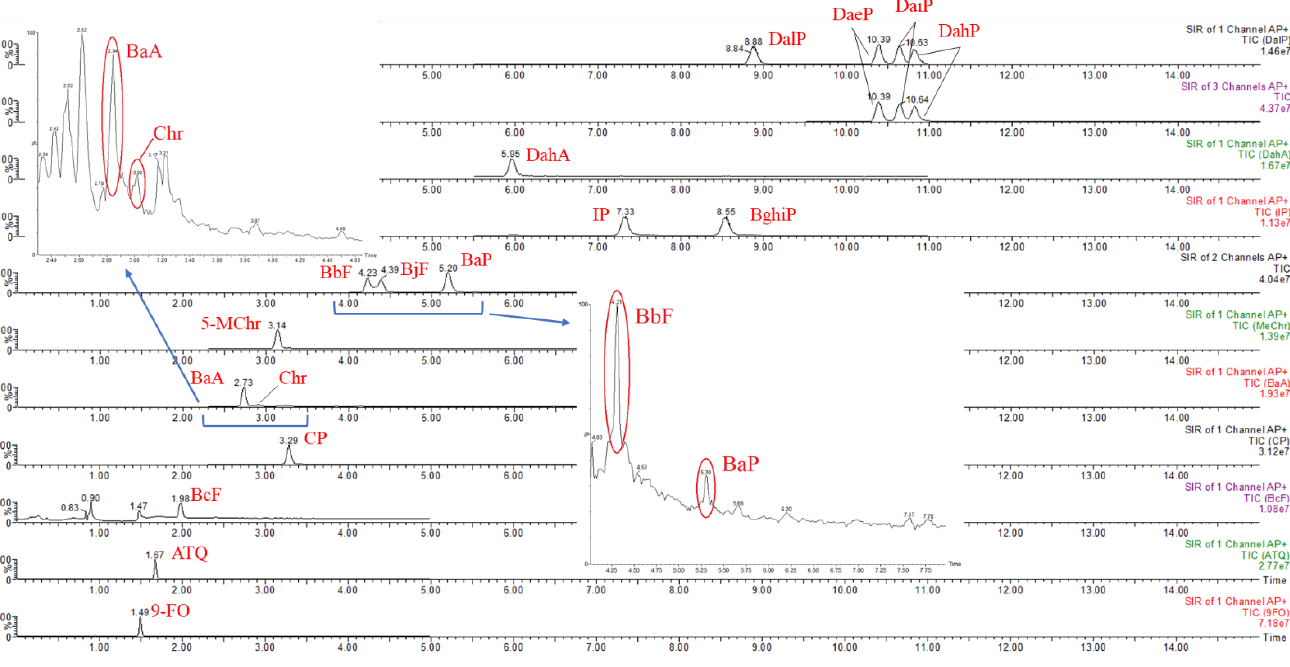
Figure 2. Optimized SFC-QqQ-MS chromatograms of 17 PAHs standards (200 µ g/kg) and PAH4 in real milk samples.